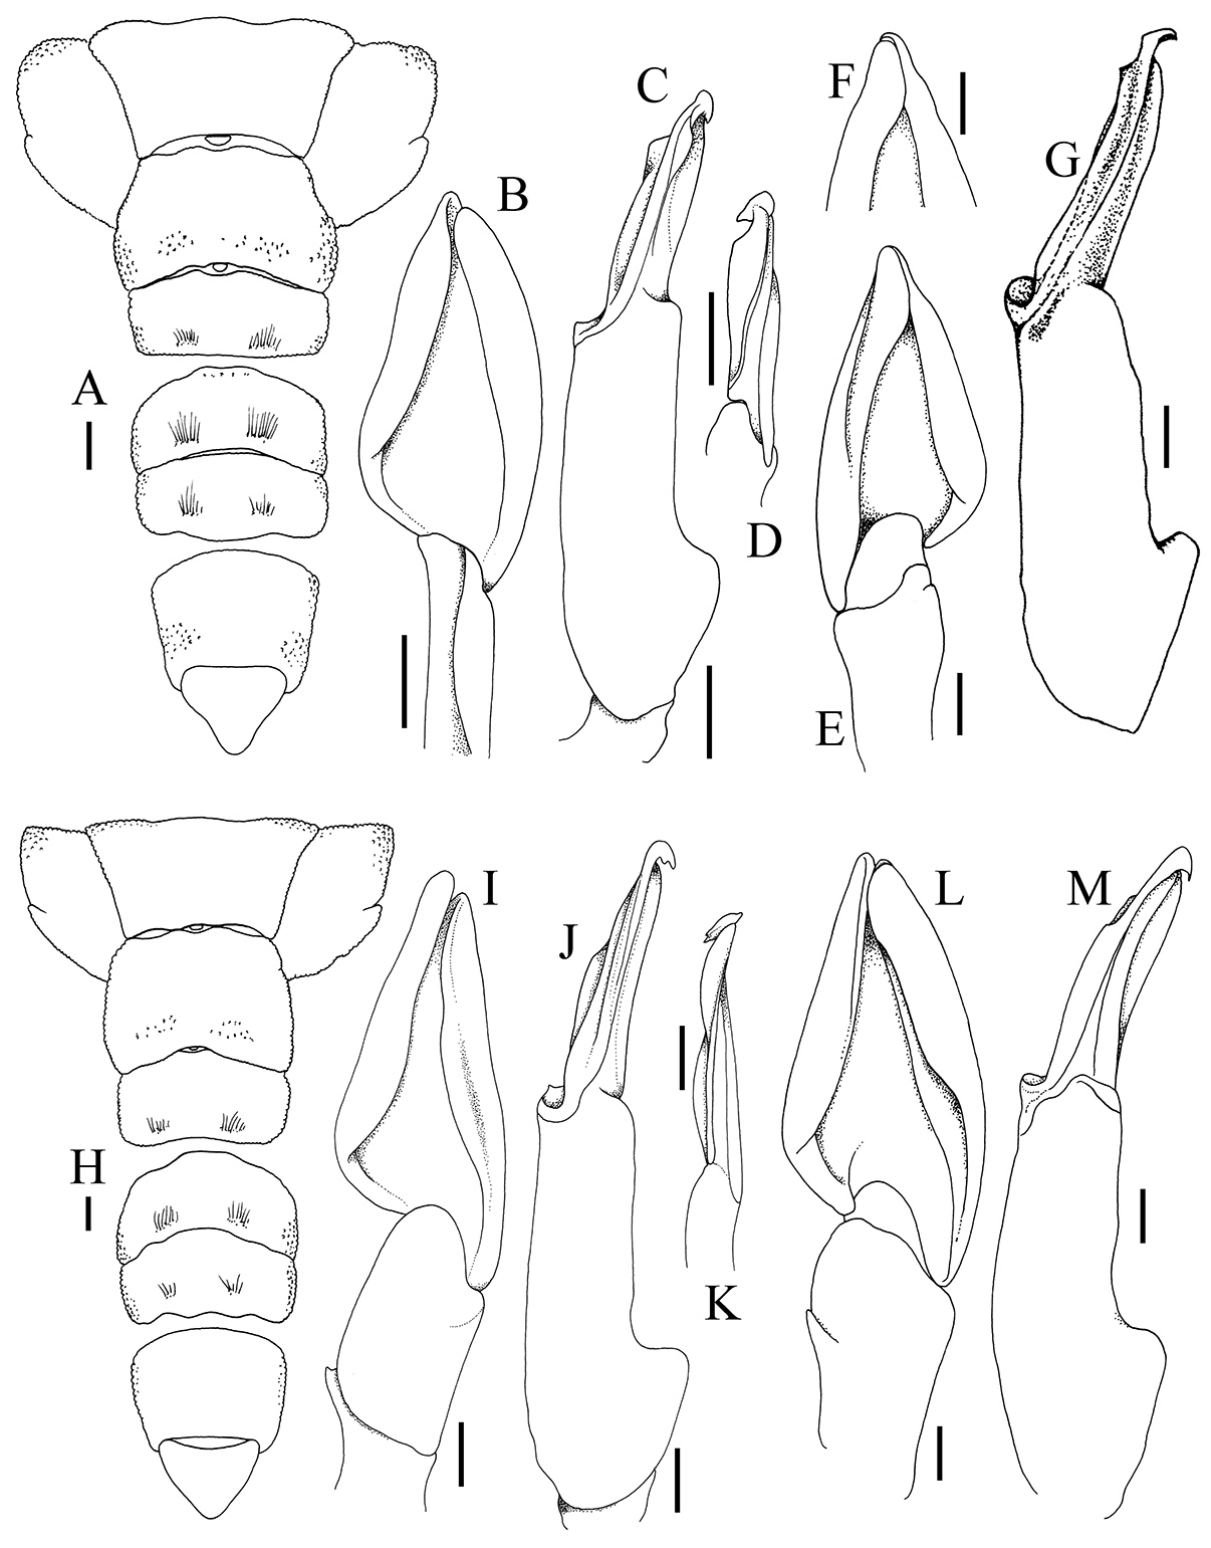
Figure 6. Umalia trirufomaculata , A, E–G, holotype male (20.4 x 26.3 mm) (WAM 348-60), Australia; B–D, U. trirufomaculata , male (11.8 x 15.6 mm) (ZSI), Andamans; H, L, M, U. misakiensis , male (23.4 x 28.9 mm) (ZRC 2018.1378), Philippines; I–K, U. misakiensis , male (16.0 x 21.8 mm) (ZRC 2001.0637), Philippines. A, H, male pleon (lateral setae not drawn); B, I, L, left G1 (inner lateral view); C, J, M, left G2; D, K, distal part of left G2; E, F, right G1 (inner lateral view); G, right G2. G after Davie and Short (1989: fig. 8b). Scale bars: A, H = 1.0 mm; B–G, I–M = 0.5